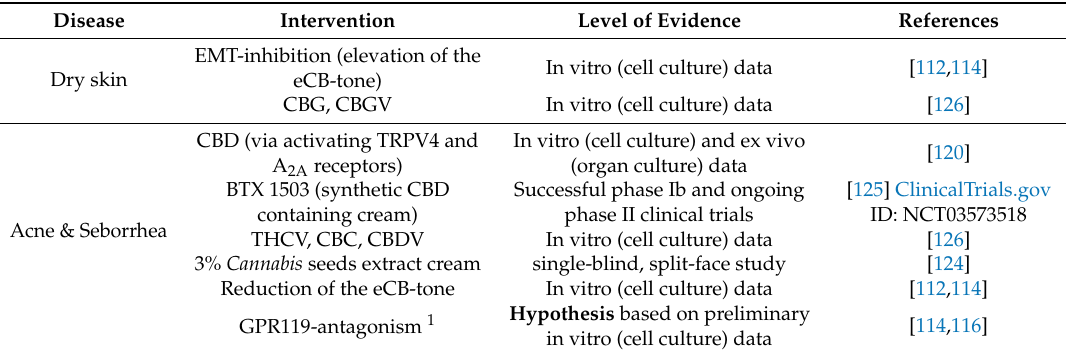
Table 1. Overview of the putative sebaceous gland-relevant therapeutic potential of cutaneous cannabinoid